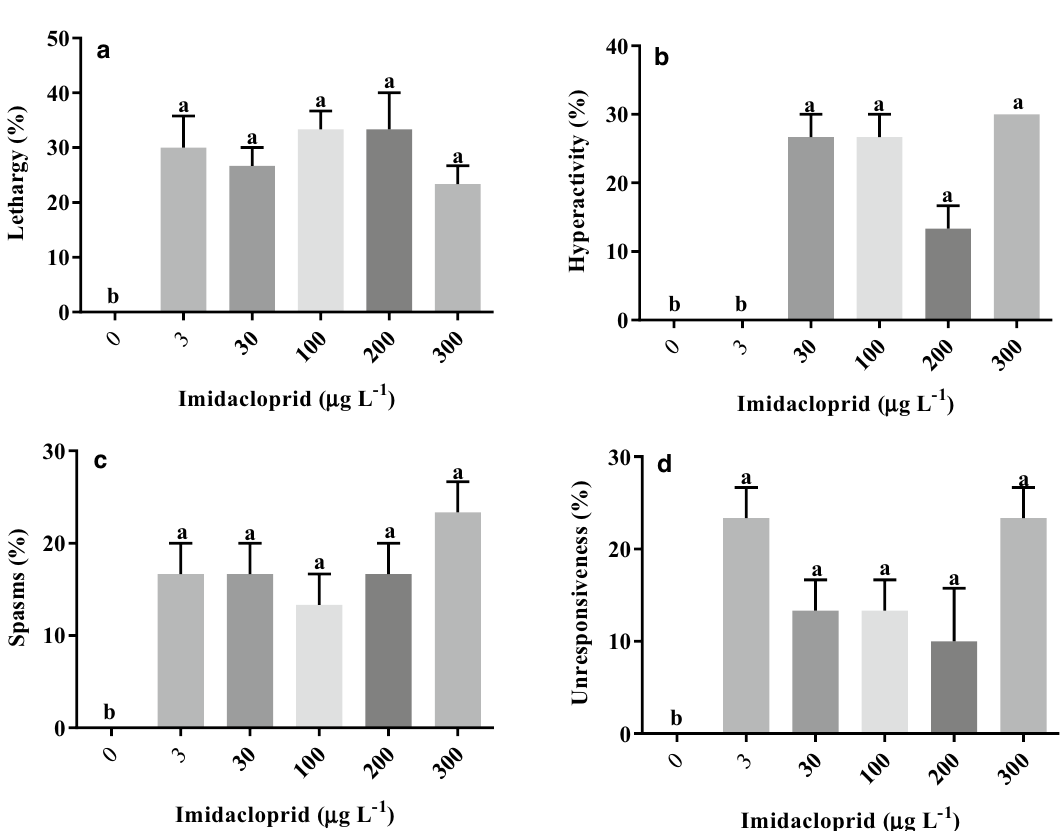
Figure 4. Frequency of lethargy ( a ), hyperactivity ( b ), spasm ( c ), and unresponsiveness ( d ) in Leptodactylus luctator tadpoles exposed to an imidacloprid-based insecticide for 168 h. The bars represent the mean ± SEM ( n = 3). Different letters above pairs of columns indicate significantly different results according to Dunnett’s test ( p <